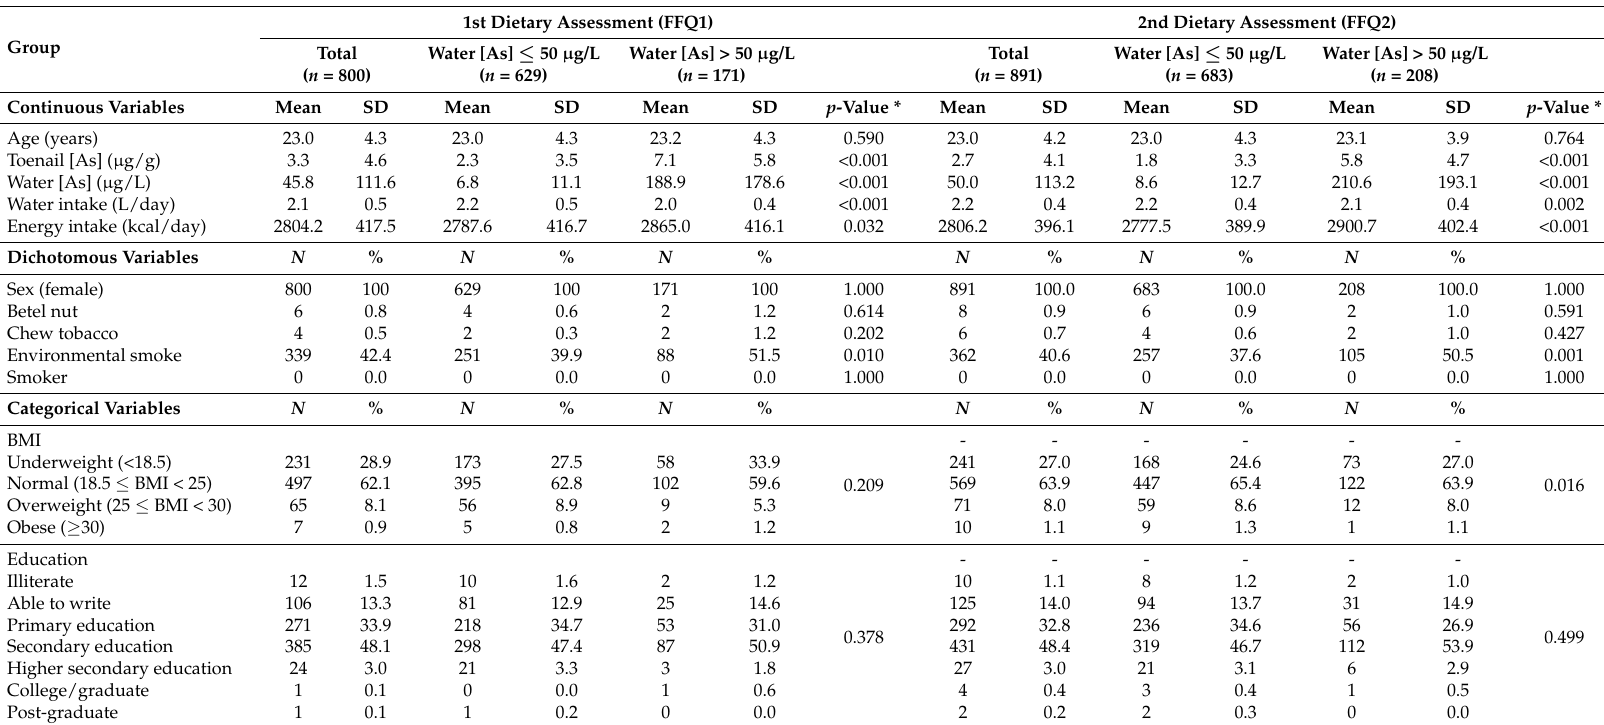
Table 1. Demographic characteristics of the study population across the two dietary assessment